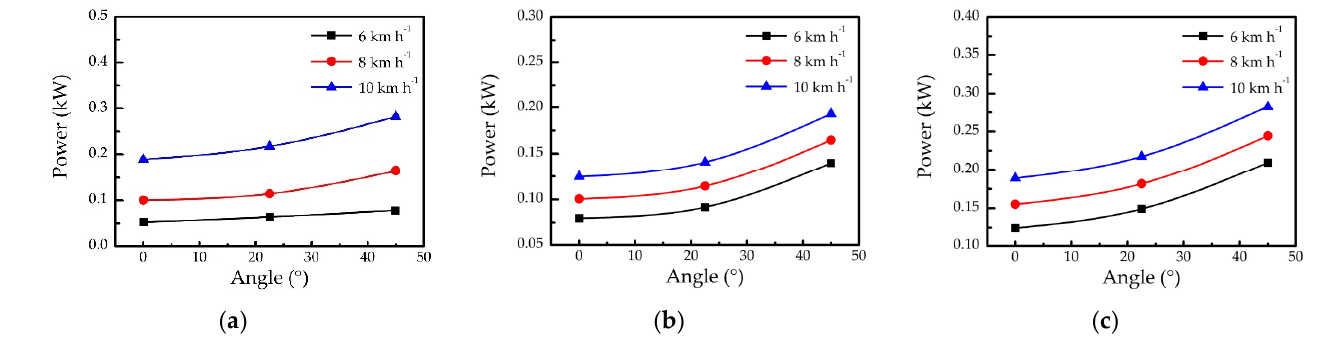
Figure 8. The relationship between power, operating angle, operating depth and operating speed. ( a ) The relationship between operating angle, operating speed and power at the operating depth of 60 mm. ( b ) The relationship between operating angle, operating speed and power at the operating depth of 70 mm. ( c ) The relationship between operating angle, operating speed and power at the operating depth of 80 mm.